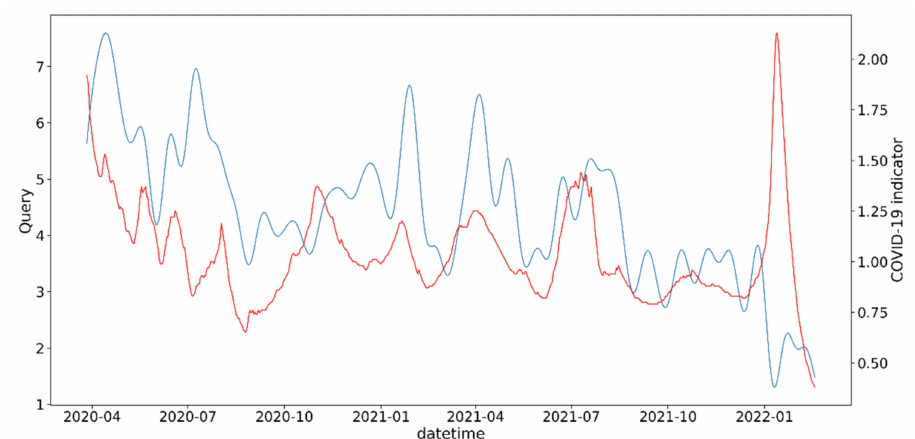
Figure A10. COVID-19—Reproduction rate. Query—vaccination COVID-19 vaccination.